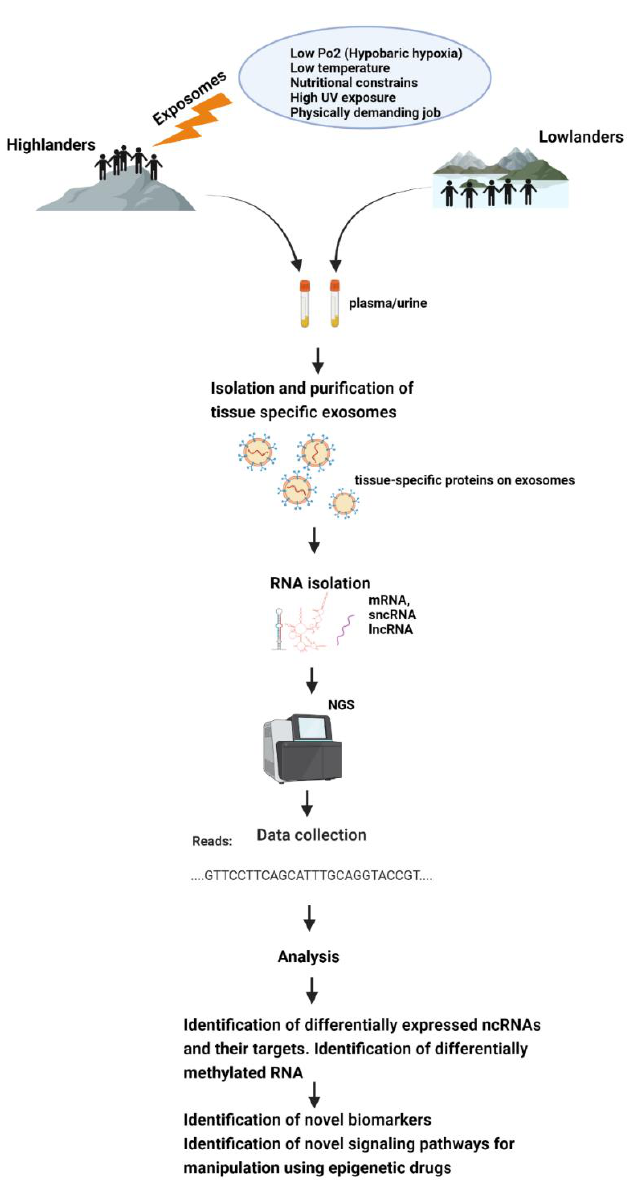
Figure 2. Schematic representation of how exposomes affect the epigenome of high-altitude dwelling living organisms—which could be studied using exosomes.